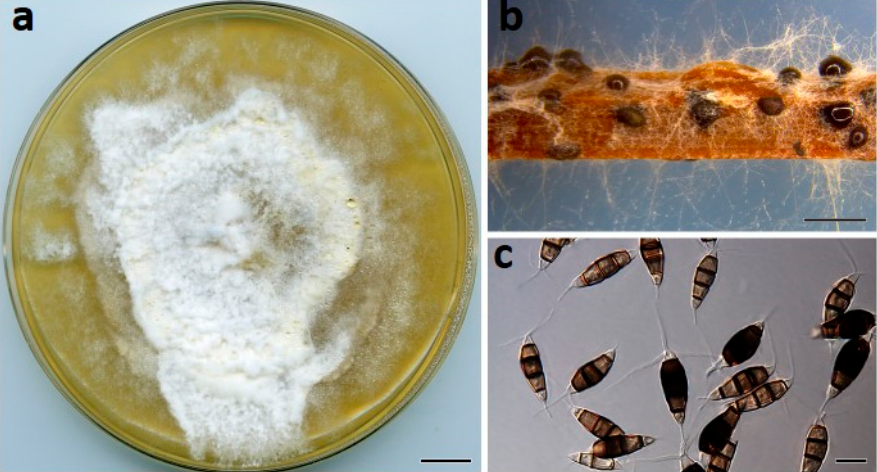
Figure 6. Neopestalotiopsis vheenae (BRIP 72293a). ( a ) Two-week-old colony on PDA, ( b ) conidiomata on pine needle agar, and ( c ) conidia. Scale bars: a = 1 cm; b = 1 mm; c = 10 µm. MycoBank: MB840919.